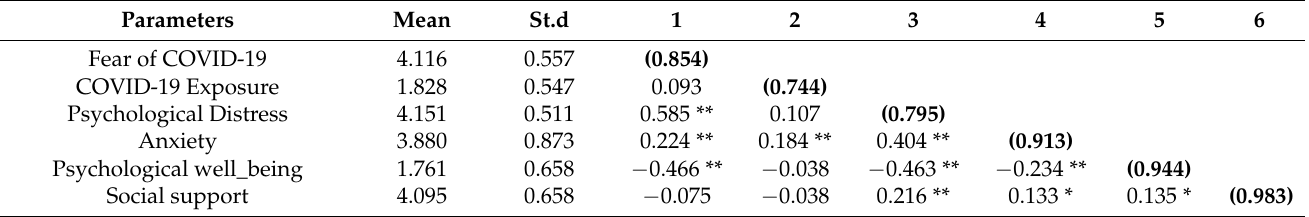
Table 3. Descriptive Statistics, Reliabilities and Correlation